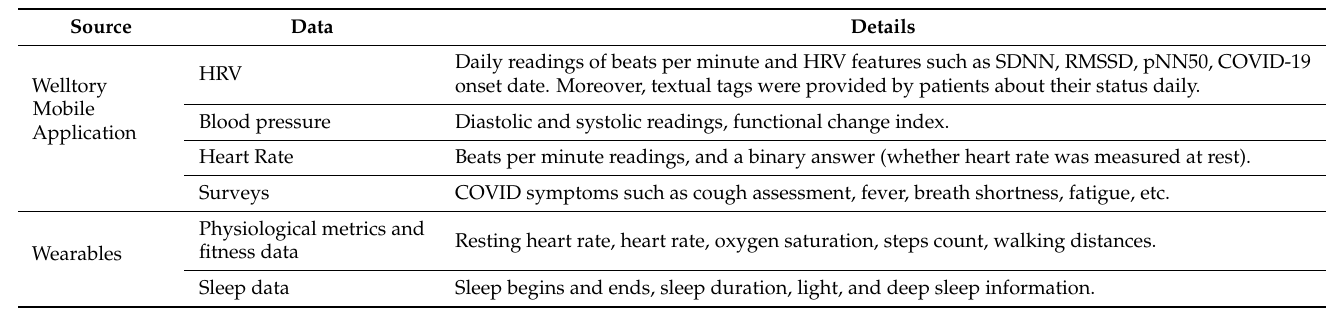
Table 1. Dataset Table 1. Dataset Description.